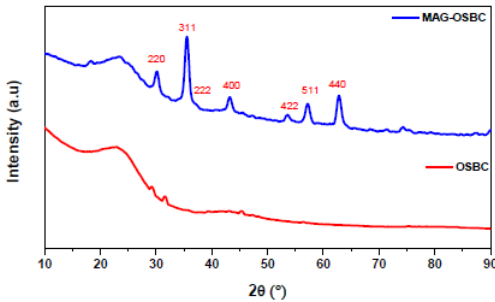
Figure 7. Powder XRD pattern of the OSBC and MAG–OSBC.